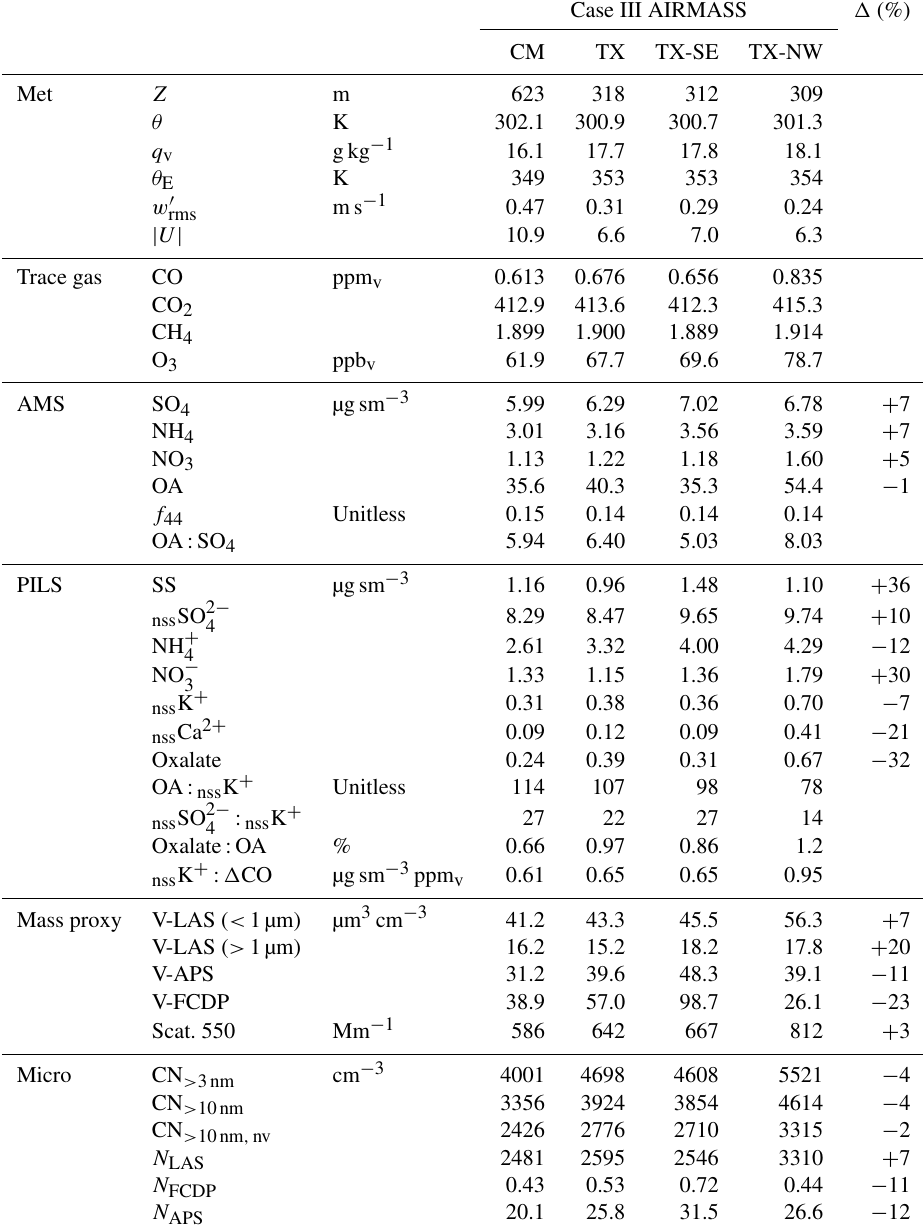
Table 4. Sub-cloud trace gas and aerosol properties for Case III at the downwind location of the cloud module (CM) and the upwind transect (TX). TX was further divided into southeastern (TX-SE) and northwestern (TX-NW) segments. (cid:49) is the dilution-adjusted percentage change from TX to CM applied to aerosol